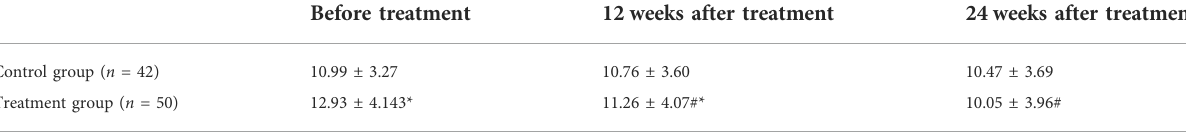
TABLE 4 Liver stiffness values at different time points before and after treatment (kpa). Before treatment